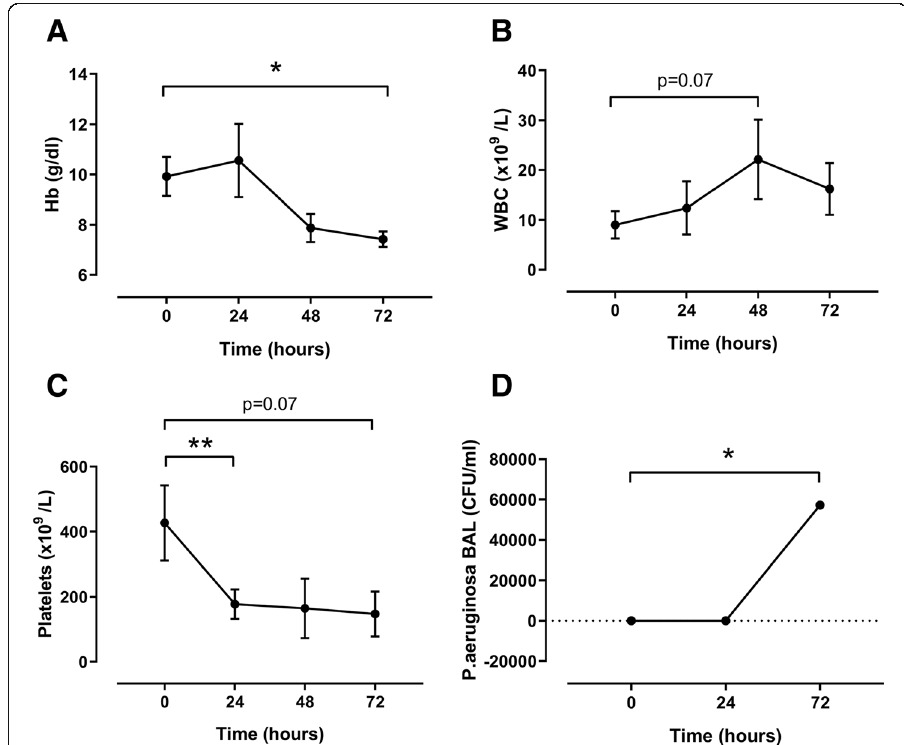
Fig. 3 Characteristics of a pig pneumosepsis model. Hb levels ( a ), WBC counts ( b ), platelet counts ( c ), and P. aeruginosa concentration in the BAL fluid ( d ) in pigs inoculated with 15 mL of 10 8 CFU of a log-phase culture of P. aeruginosa into each lung lobe. N = 5 and data are expressed as mean + SD ( n = 5). *** P < 0.001, ** P < 0.01, * P <